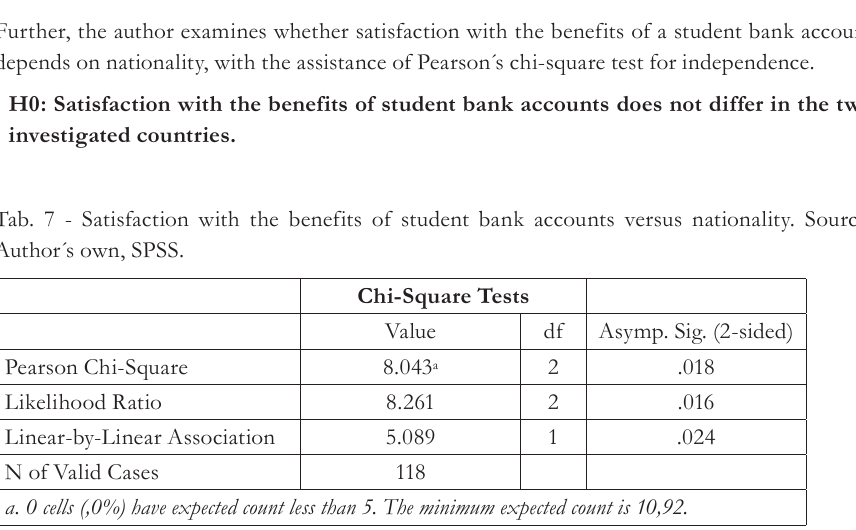
Fig. 4 – Students’ satisfaction with price of banking products and services in the two investigated countries. Source: Author´s own.